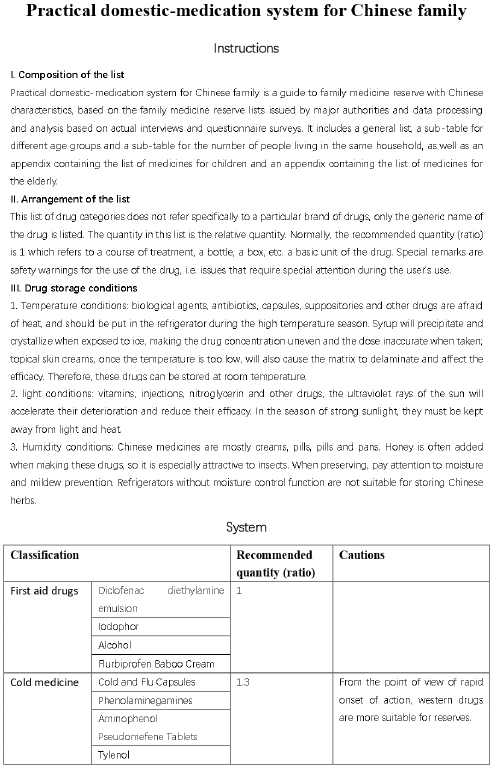
Figure 11. Frequency and importance of different types of drugs correlation analysis chart.